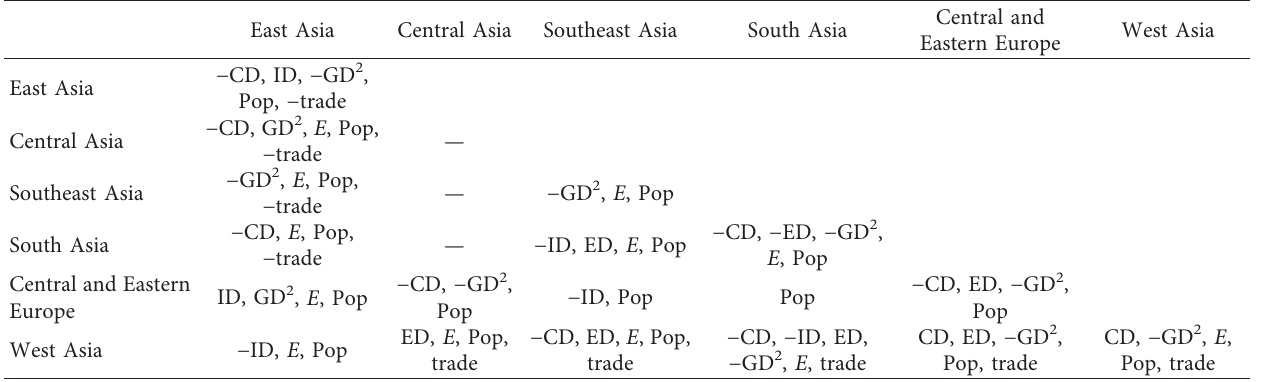
Table 14: Regression results among